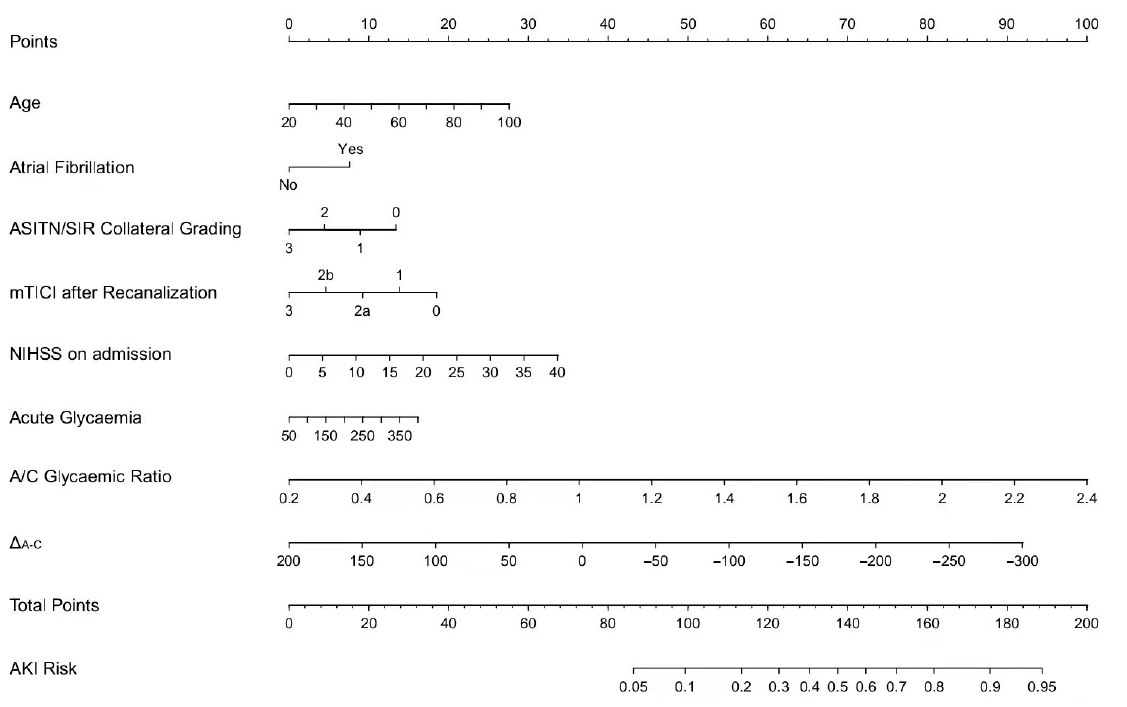
Figure 2. Nomogram predicting AKI in acute ischaemic stroke patients receiving EVT.